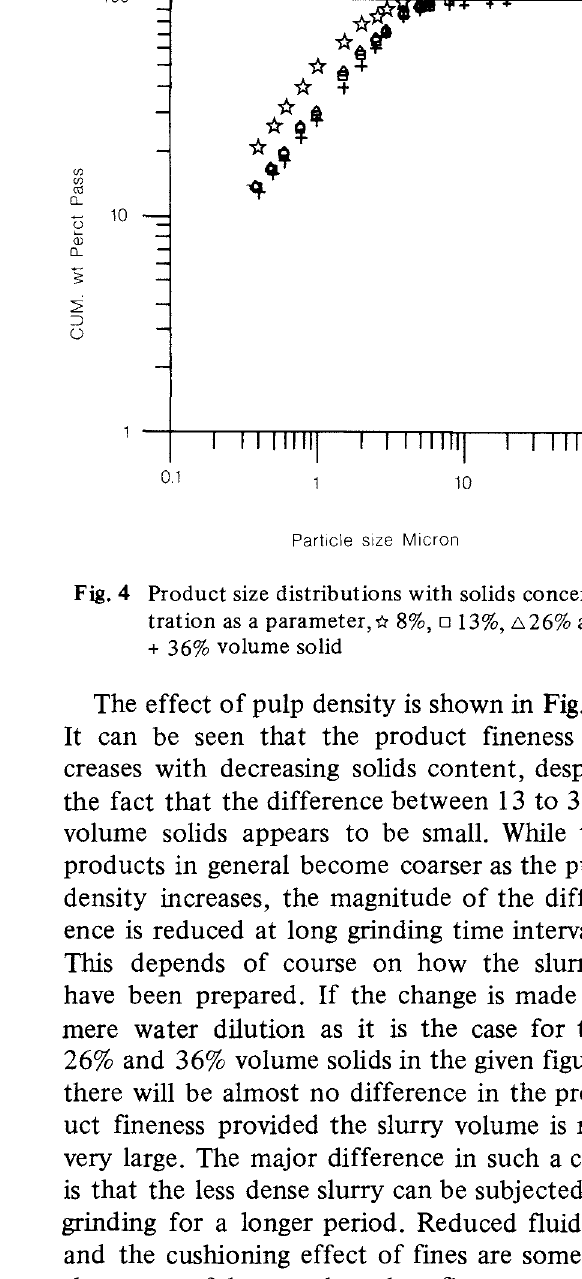
Fig. 3 Product median size as a function of the net energy input with the stirring speed as parameter, o 10 and -tr 16 mjs